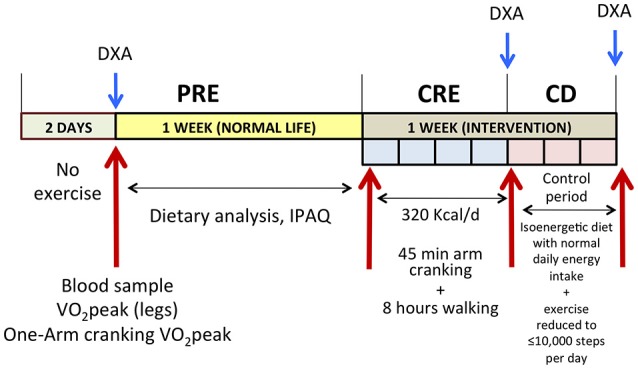
Schematic illustration of the experimental protocol. PRE, baseline tests; CRE, caloric restriction (13.4 kJ/day) and exercise (45 min arm cranking and 8 h walking per day), for 4 days; CD: 3 days on a diet, isoenergetic with that observed during the PRE phase + reduced exercise; DXA, dual-energy x-ray absorptiometry; IPAQ, international physical activity questionnaire.